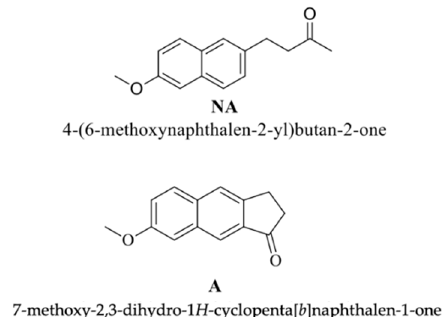
Figure 1. Chemical structures of Nabumetone (4-(6-methoxy-2-naphthyl)butan-2-one) (NA) and its analog A.